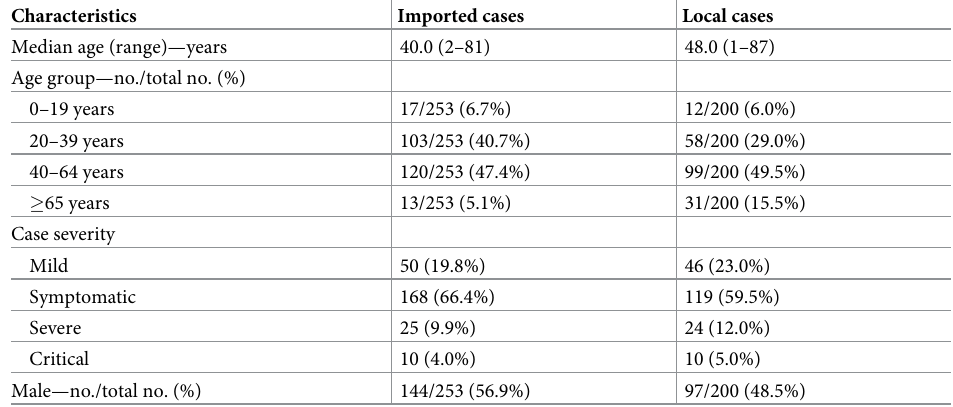
Table 2. Characteristics of laboratory-confirmed COVID-19 cases in Sichuan province disaggregated by locally acquired infections and infected individuals with travel history to Wuhan/Hubei.